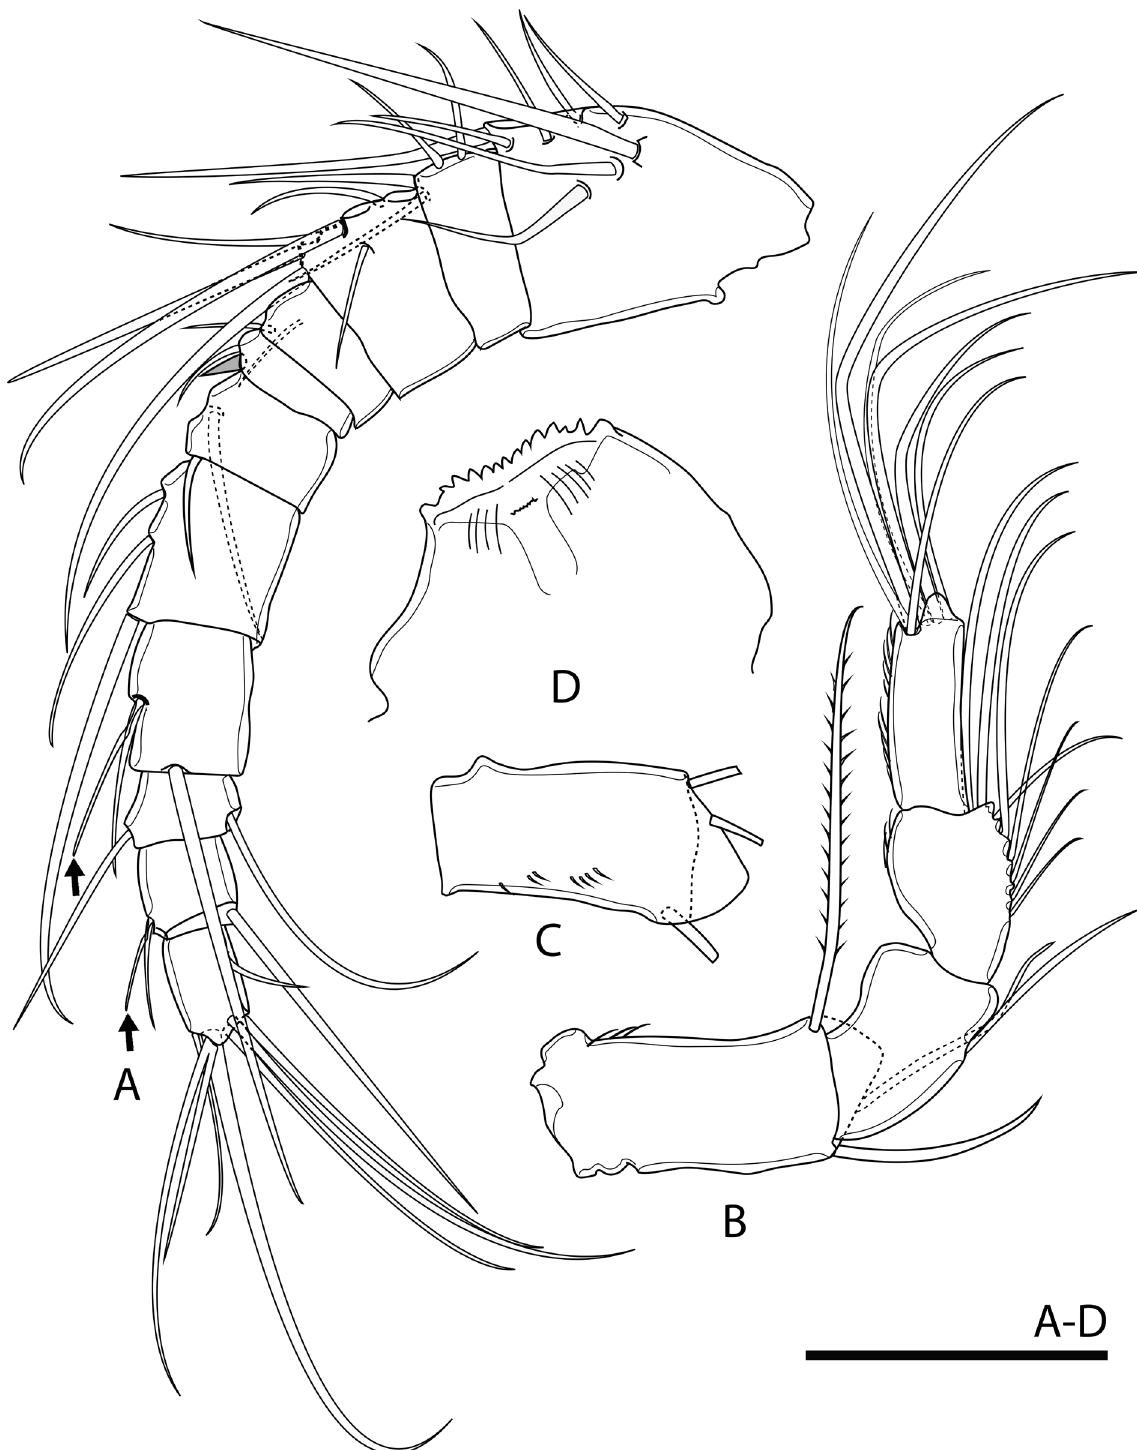
Fig. 5. Metacyclops sakaeratensis sp. nov., holotype , ♀ (A−B; ZMB 34230 slide No. 5120) and paratype, ♀ (C−D; ZMB 34230 slide No. 5122). A . Antennule (arrows indicate aesthetascs). B . Antenna, frontal surface. C . Coxobasis of antenna, caudal surface. D . Labrum, inner side. Scale bar = 50